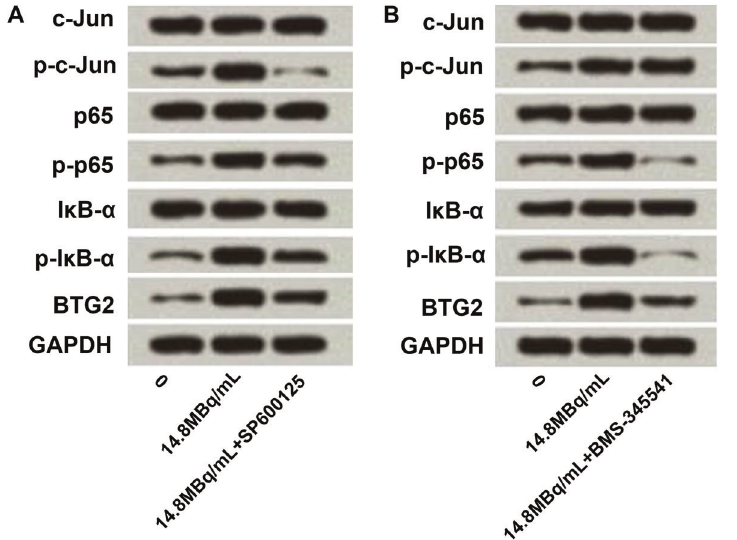
Figure 4. A and B , Iodine-131 up-regulated BTG2 expression by activation of JNK/NF- k B